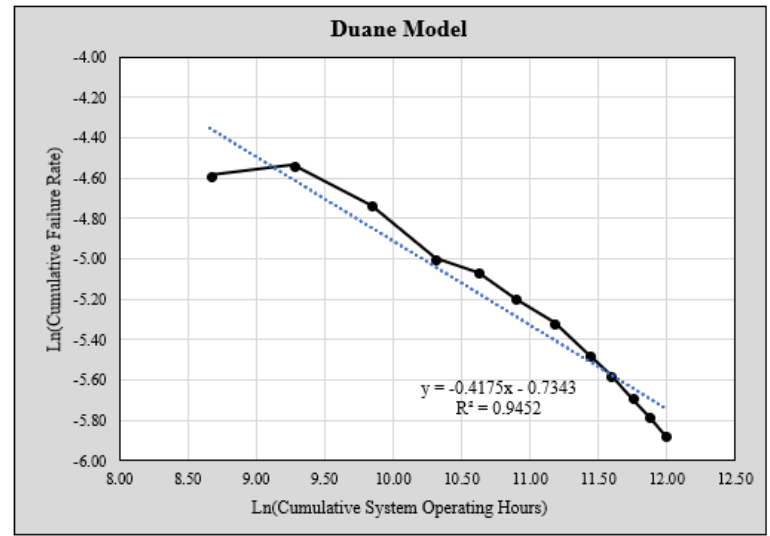
Figure 4. Plot of ln (Cumulative failure rate) vs. ln (Cumulative system operating hours) The slope of the straight line through the data is the estimated reliability growth rate, α = 0.4175. ln λ is the y -intercept = -0.7343, λ = 0.4798. 0 0 According to equation